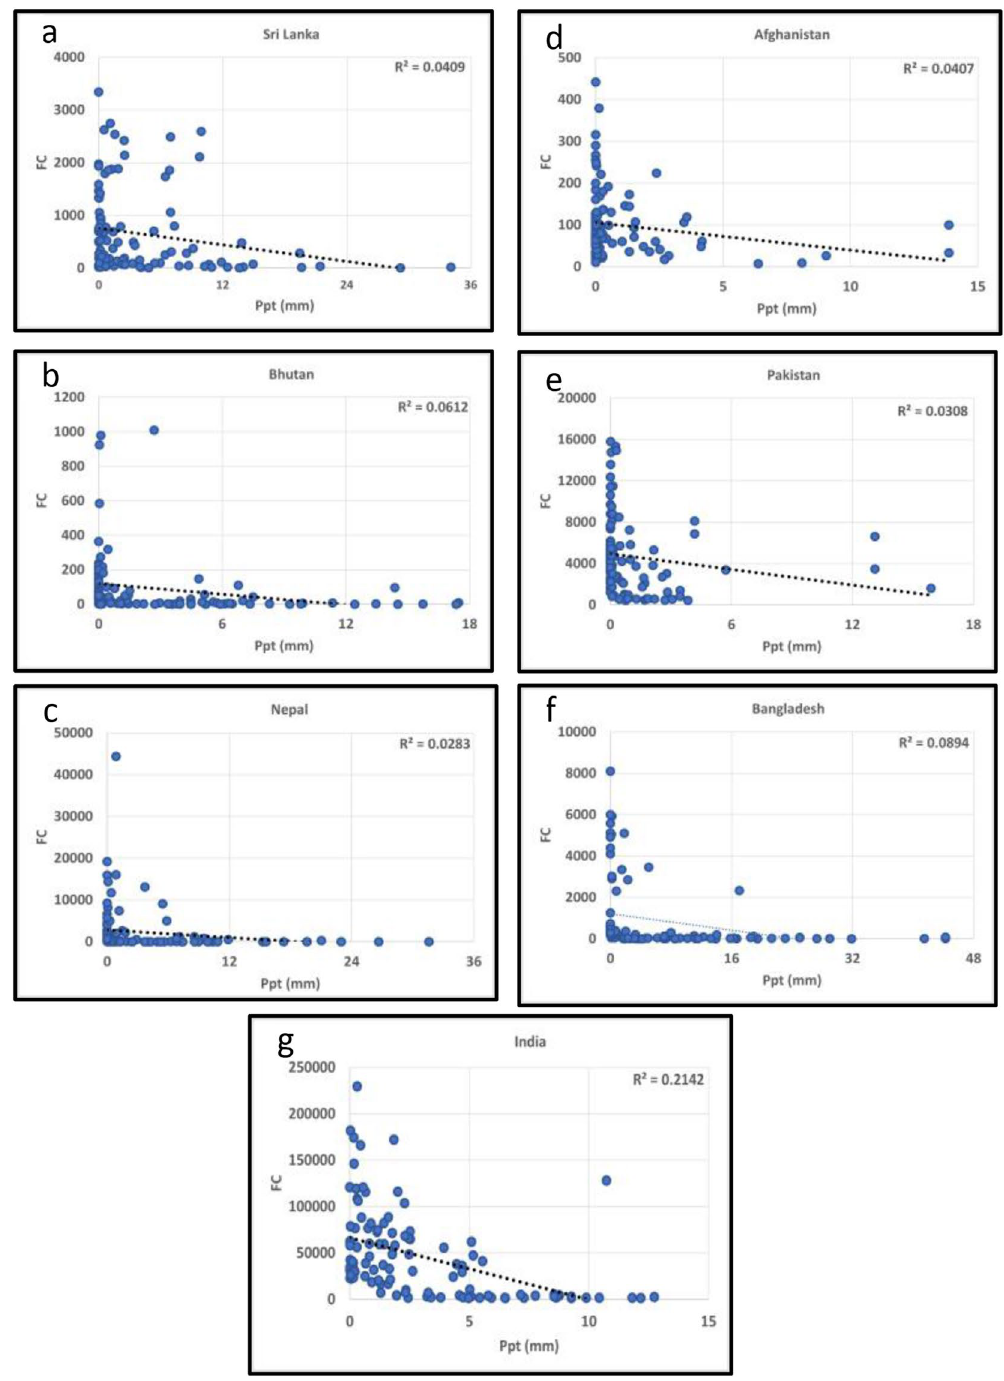
Figure 9. ( a )–( g ) Fire Counts (FC)-Precipitation (Ppt) relationships in South Asian countries. Most of the correlations were